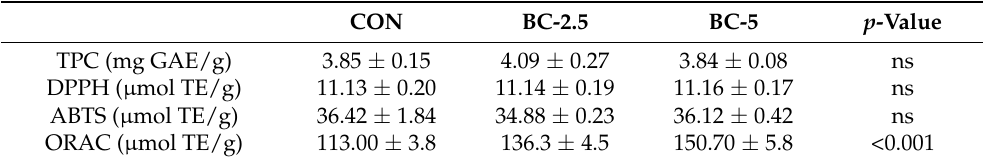
Table 3. Total phenol contents and antioxidant activities of experimental diets, as measured using different methods (values are given as a mean ± SD of three independent measurements). CON BC-2.5